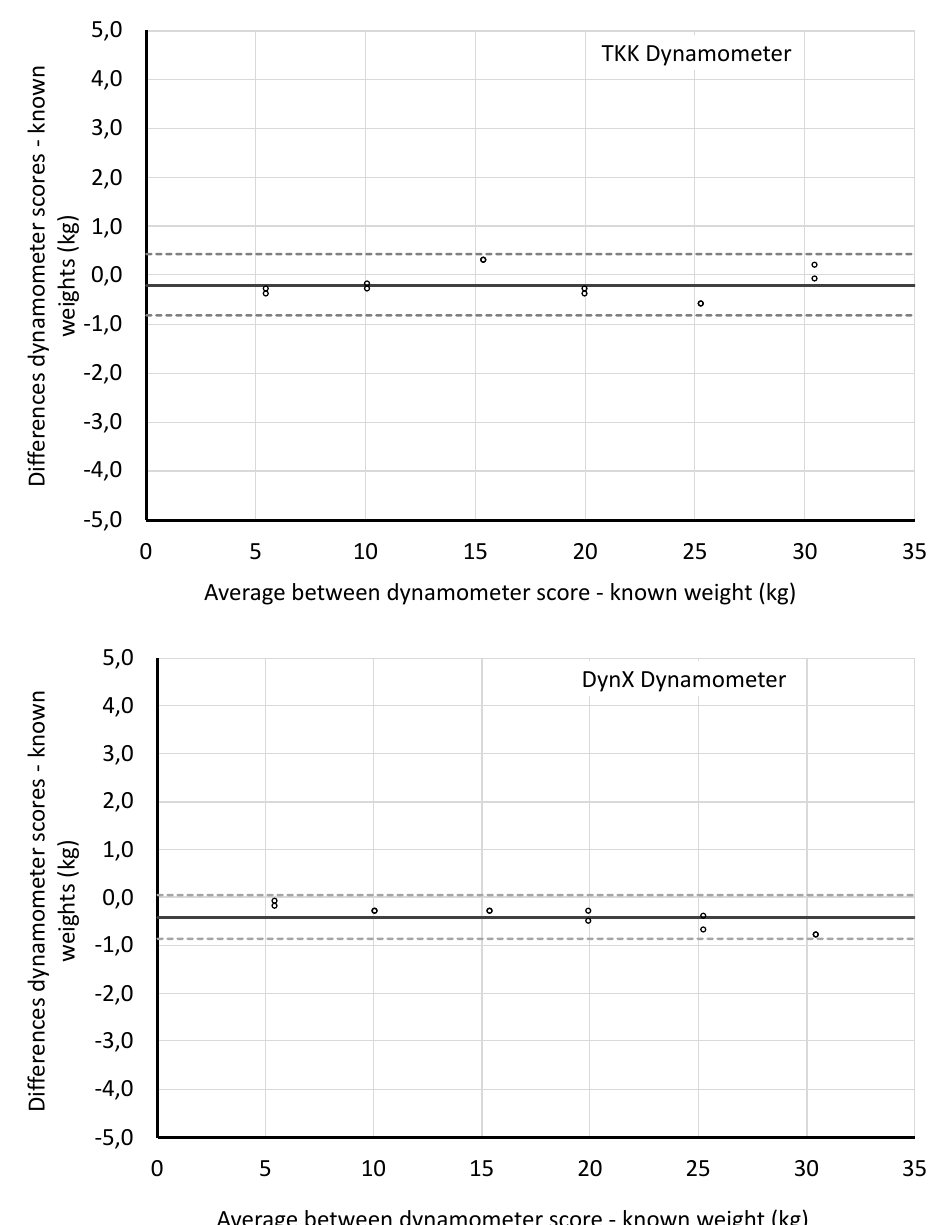
Figure 3. Validity between the TKK and DynX dynamometers and known weights by Bland and Altman plots [32]. The central line shows the mean difference (bias) between the dynamometer weight score and the known weight. The upper and lower lines represent 95% limits of agreement (mean difference ± 1.96 SD of